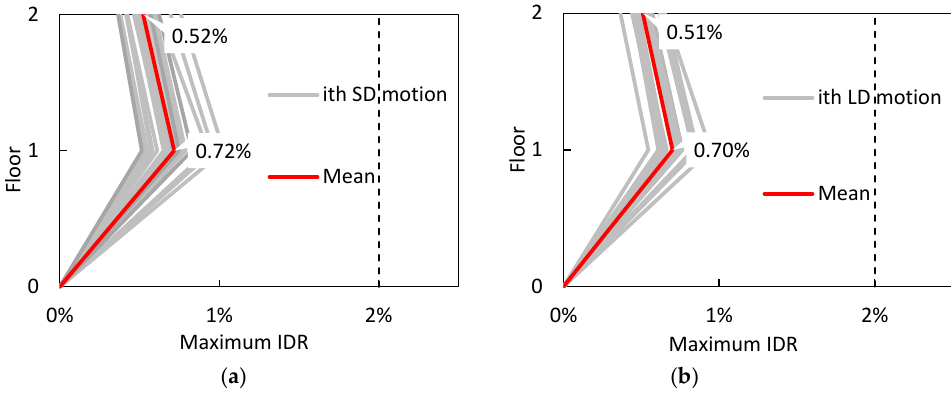
Figure 8. Maximum IDR for ( a ) SD and ( b ) LD motions.